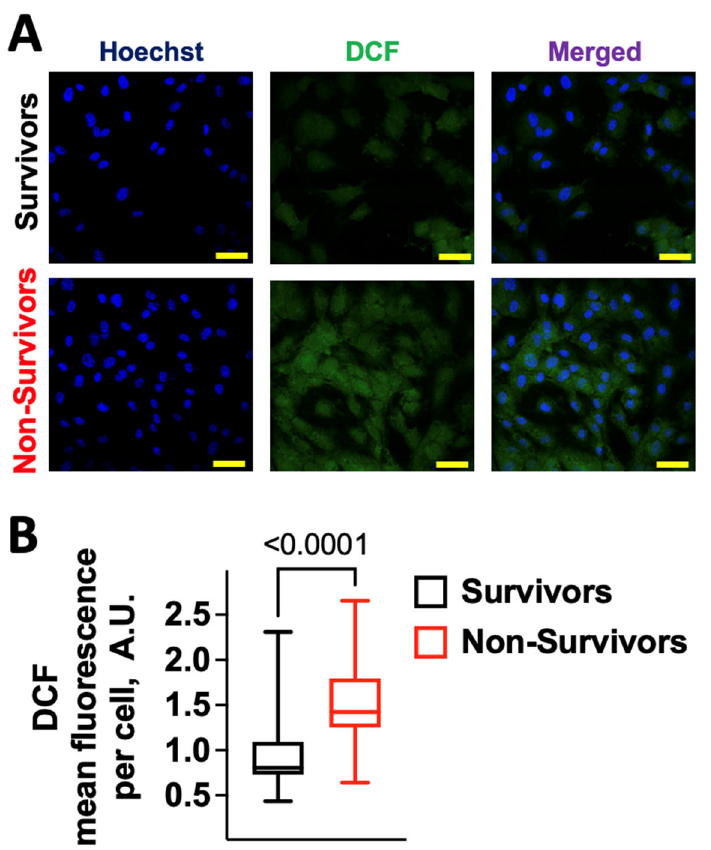
Figure 1. Serum from patients who did not survive COVID-19 promotes oxidative stress in human endothelial cells. ( A ) Representative microphotographs of DCF and Hoechst staining of HUVECs treated for 24 h with 10% serum obtained on hospital admission from patients who survived or succumbed to COVID-19; scale bar: 50 µ m. ( B ) Quantification of DCF fluorescence intensity. Data were obtained from at least three independent experiments and are presented as a box-and-whiskers plot showing the median and the 5th–95th percentiles; A.U.: arbitrary units.